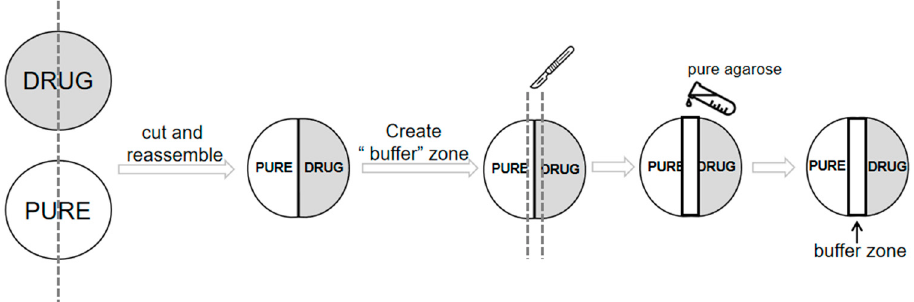
Figure 5. Creating a feeding assay plate. The same volume of prepared agarose solutions with or without the drug was poured into different 60 mm Petri dishes. The drug plate (DRUG) and PURE plate (no drug) were divided into two pieces and recombined. In order to better bridge the two parts of the new plate and establish an area for the larvae to freely choose, a 0.8 cm-wide middle zone was created in the middle of the plate with a sharp knife and refilled with pure agarose. All larvae to be tested were initially placed in the middle area before taste and feeding tendency assays started.